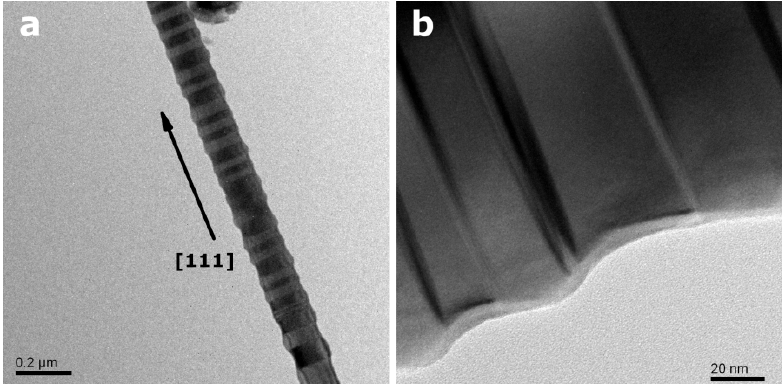
Figure 3. TEM image of more regularly twinned ZB-type InP NWs grown along [111].